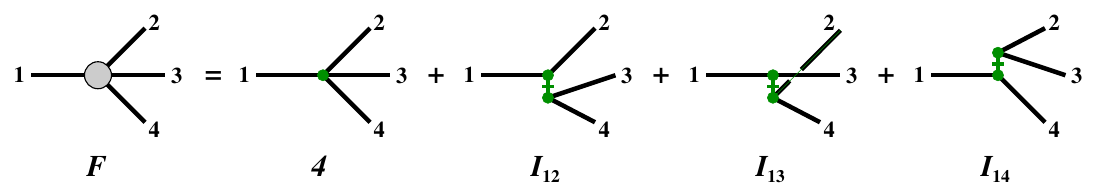
Figure 7 . The meaning of the circular blob (“F”) in terms of the fundamental 4-gluon vertex (“4”) and LCPT instantaneous longitudinal gluon exchange in various channels ( I 12 , I 13 , I 14 ). The green color here has no meaning other than to highlight the interactions that make up the circular blob.